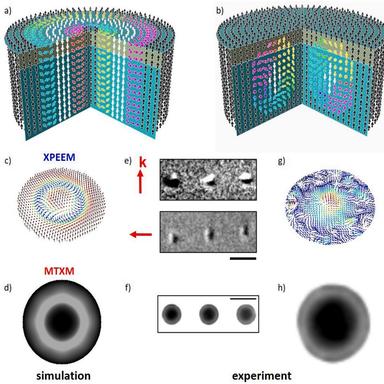
Schematic spin texture in a nanodisk for a) the Target Skyrmion and b) the Hopfion, showing the stark differences throughout the thickness of the disk. c, d) Simulations of the expected X-PEEM and MTXM contrast for the Hopfion structure. e) X-PEEM data for two orthogonal orientation relative to the incoming photon beam, which are used to obtain a 3D reconstruction of the near-surface magnetization. f) Representative experimental MTXM data. g), h) Experimental data for X-PEEM and MTXM showing good agreement